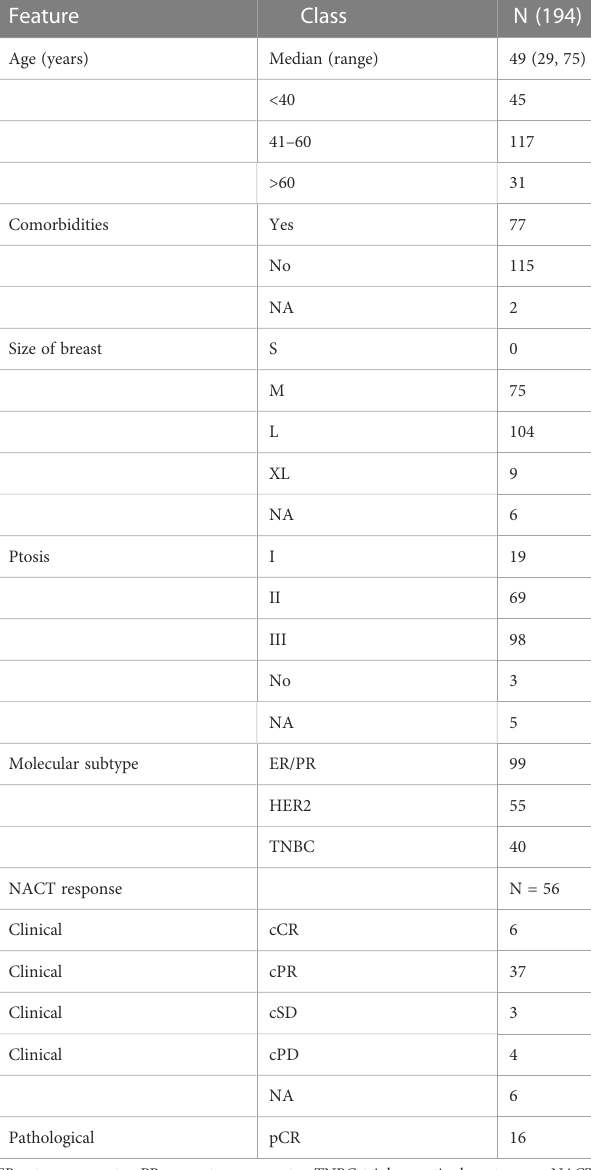
TABLE 2 Demographic distribution of breast cancer patients. TABLE 3 Clinical features of surgeries for breast